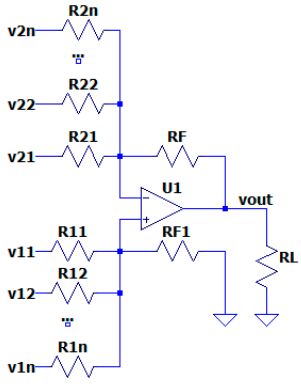
Figure 12. Summing and subtracting amplifier [44].